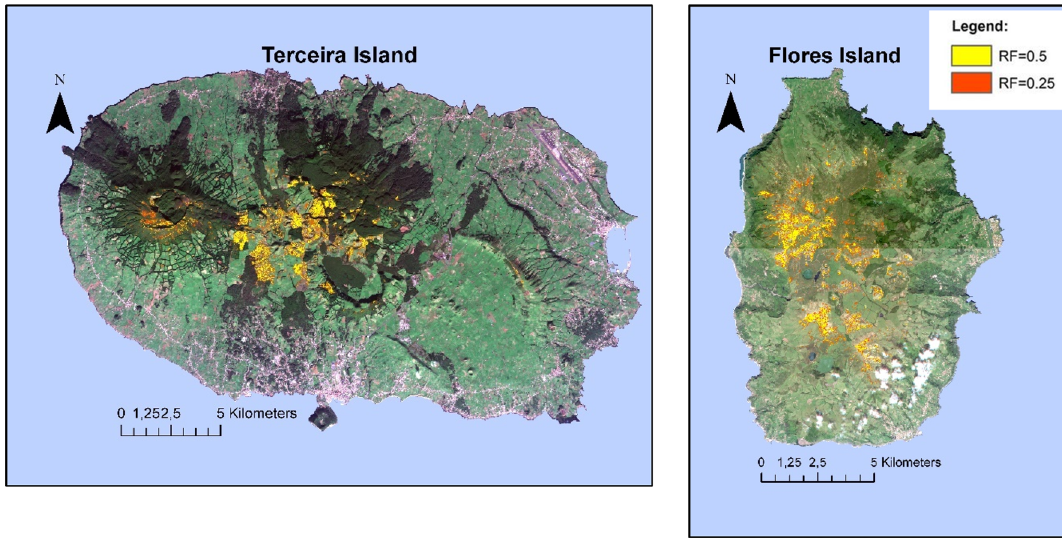
Fig. 3 Actual distribution of Sphagnum defined for Terceira and Flores Islands (cartography in ArcGIS